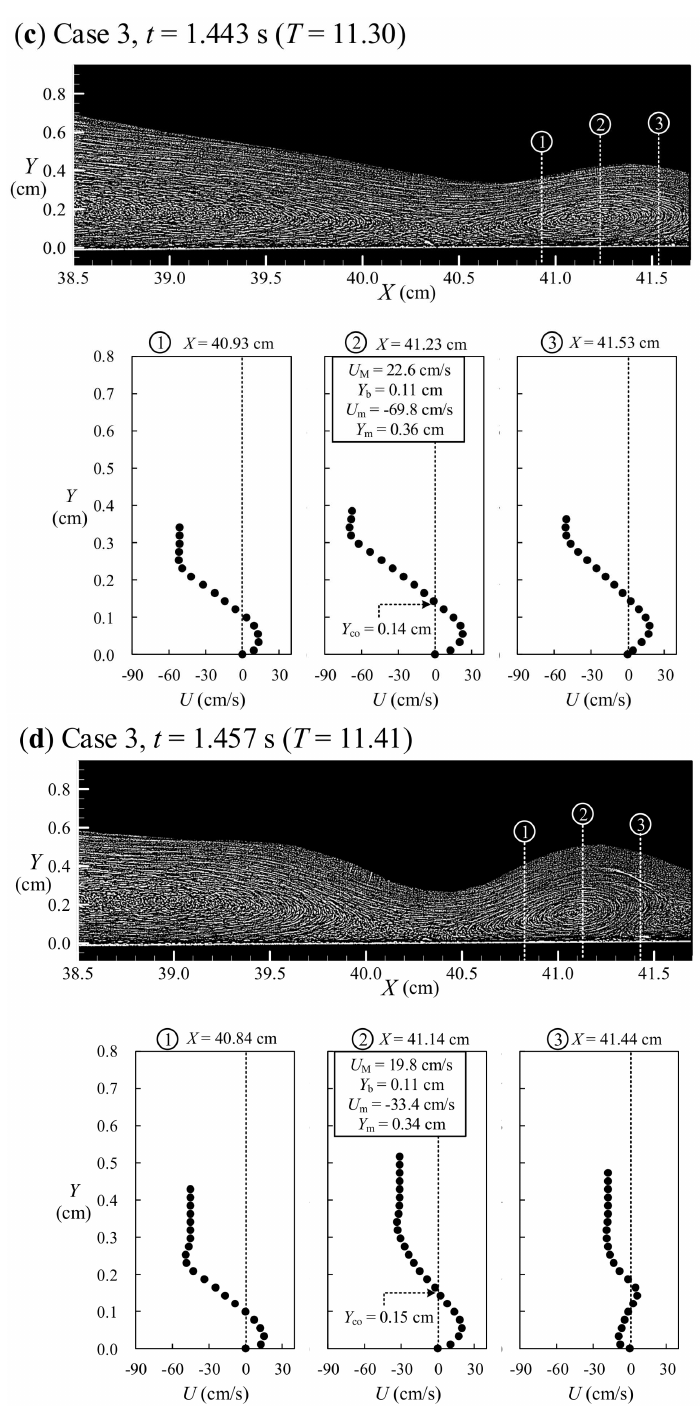
Figure A1. Flow visualization image and three velocity profiles U ( Y ) measured at and around core section of primary vortex for Case 2 at ( a ) t = 1.007 s and ( b ) t = 1.043 s; for Case 3 at ( c ) t = 1.443 s and ( d ) t = 1.457 s. Characteristic velocity and length scales U M and Y b as well as U m and Y m , together with core height Y co are shown in each subfigure 2 (cid:13)